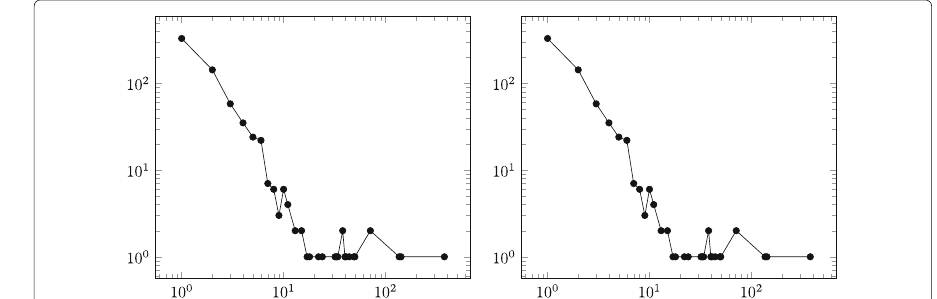
Fig. 8 Indegree distribution of M (left) and S